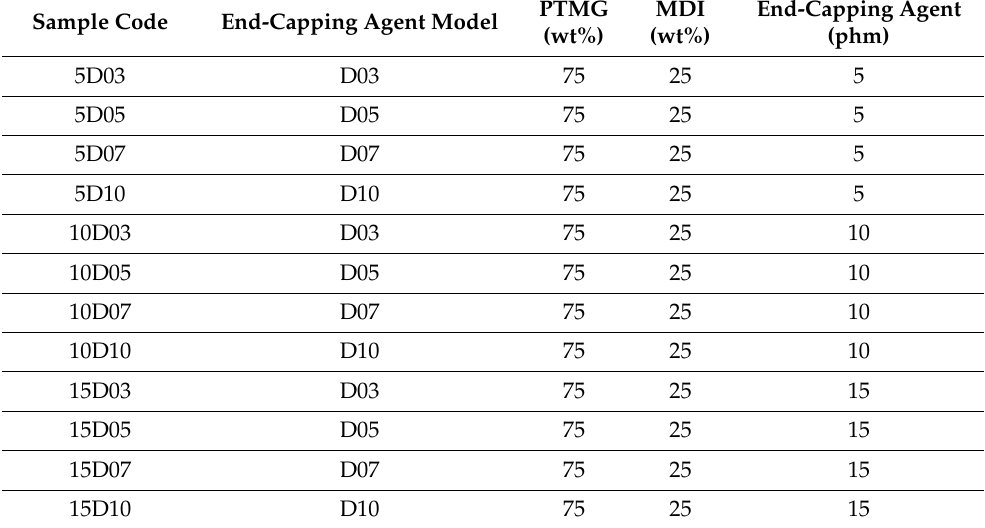
Table 2. Formula for synthetic TPU.